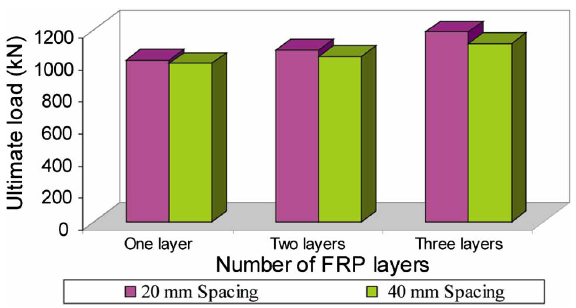
Fig. 19. Ultimate load with respect to number of CFRP layers (cid:1) comparison